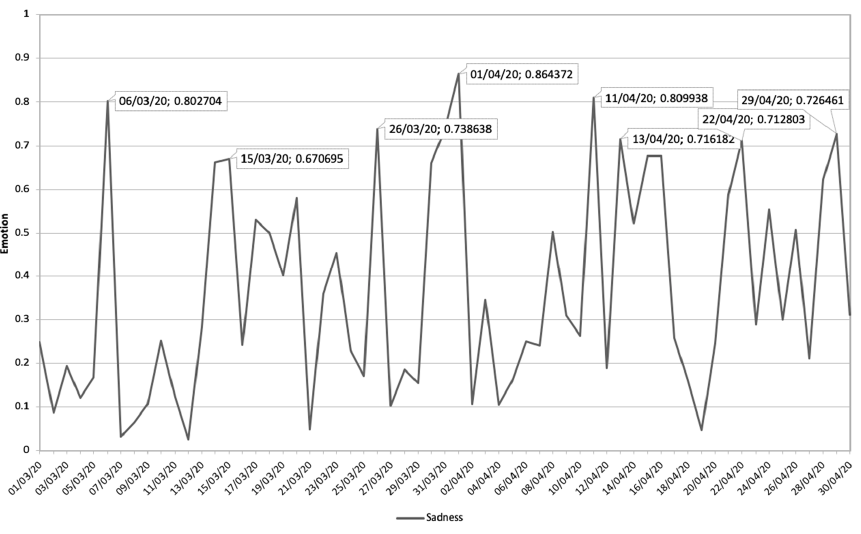
Figure 8. Fear emotion during the period 1 March 2020 until 30 April 2020 related to terms about